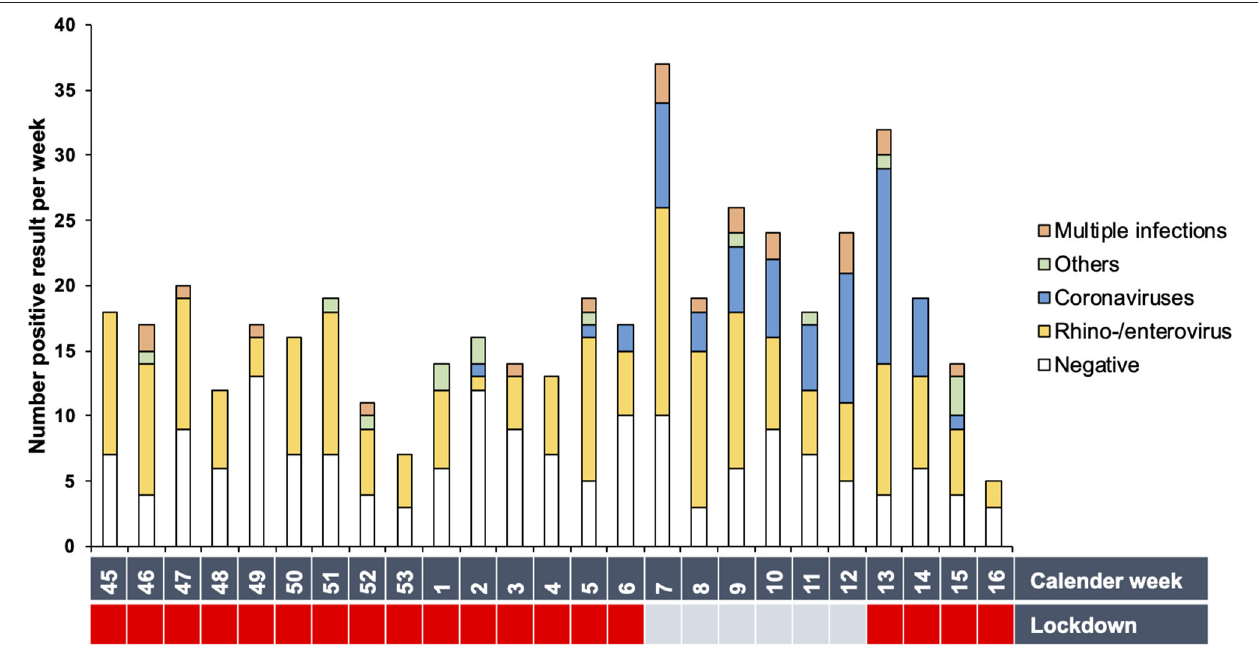
FIGURE 2 | Prevalence of detected pathogens per calendar week. Total number of positive results per week are shown. White bars represent the number of negative results. The Covid-19 regulations are depicted as lockdown (red) or lockdown-free period